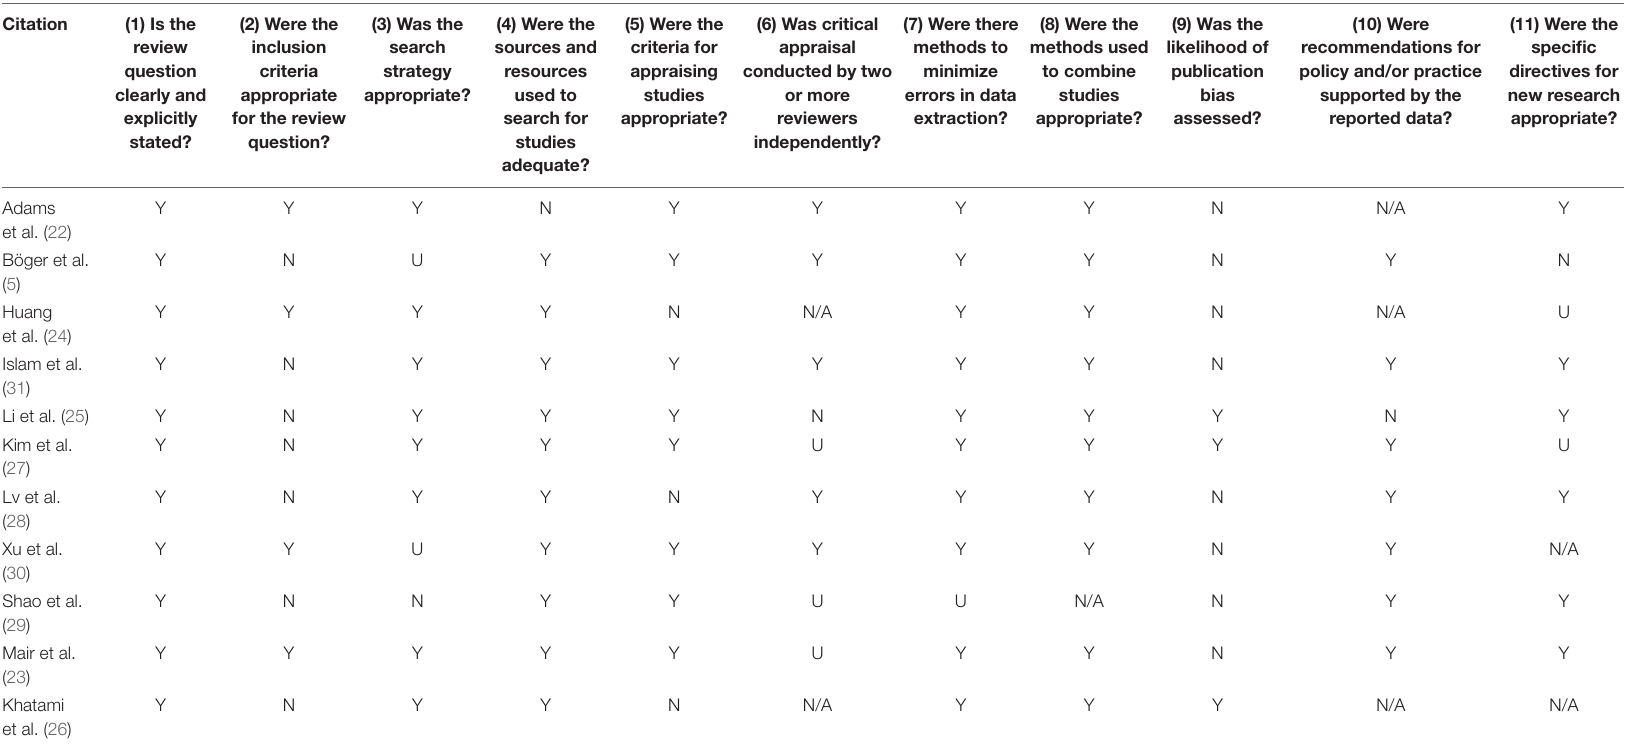
TABLE 2 | Risk of bias assessment for included systematic